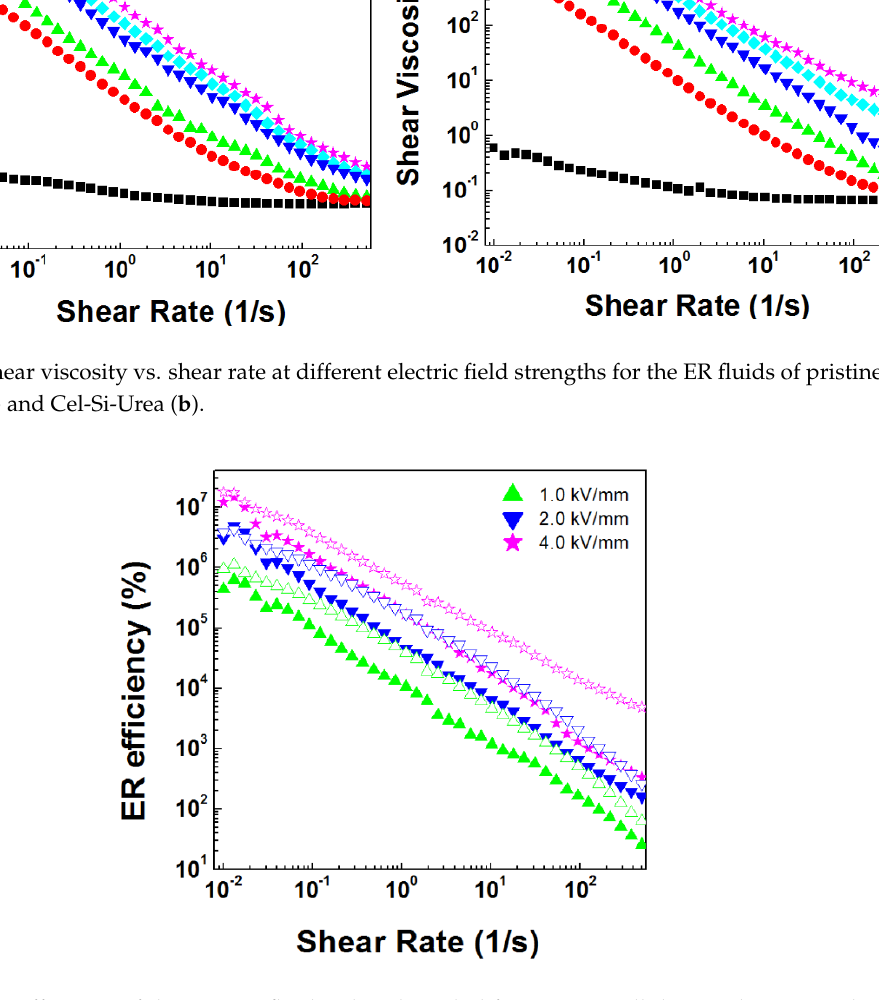
Figure 7. ER efficiency of the two ER fluids: closed symbol for pristine cellulose and open symbol for Cel-Si-Urea.